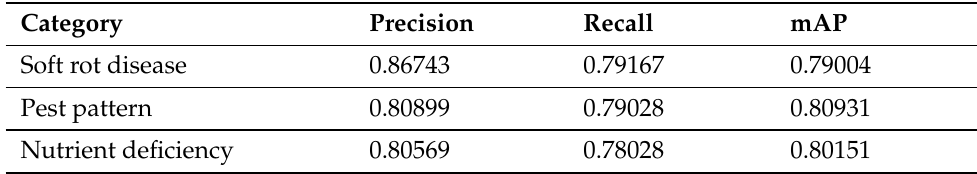
Table 6. YOLOv5 results on different ginger defects